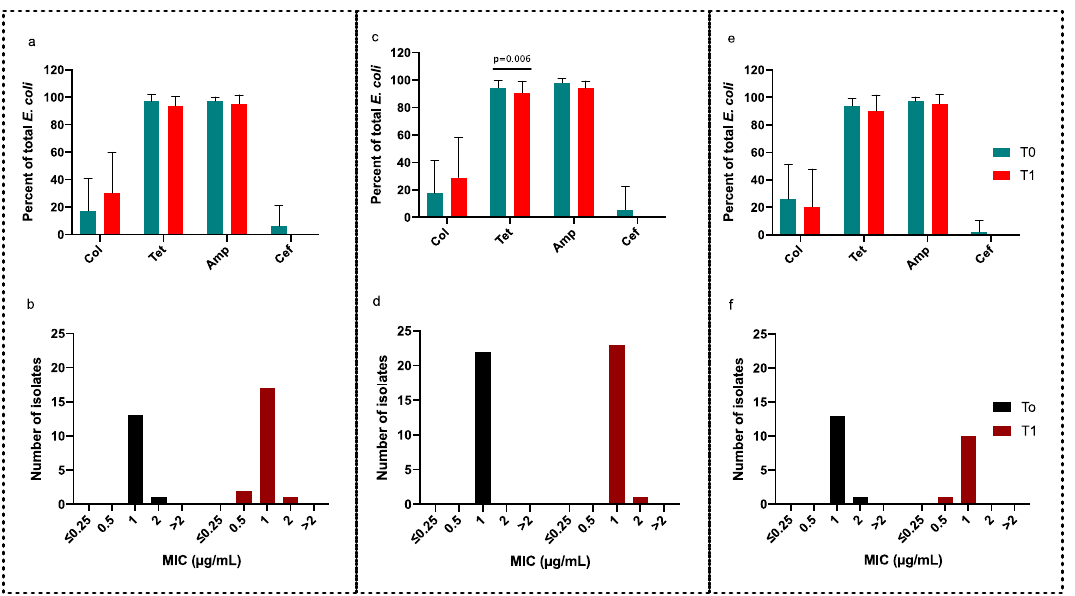
Figure 1. Percentage of resistant strains out of total E. coli and the MIC of E. coli against colistin in the different treatment groups. Treatment of pigs with colistin sulfate after the onset of diarrhea ( a , b ). Treatment of pigs with colistin sulfate before the onset of diarrhea ( c , d ). Treatment of pigs with antidiarrheal feed supplements ( e , f ). T0 and T1 refer to counts before and after treatment. Col, Tet, Amp, and Cef refer to CFU count on MacConkey agar plates supplemented with colistin, tetracycline, ampicillin, and cefotaxime, respectively. The error bars represent the standard deviation of the mean.